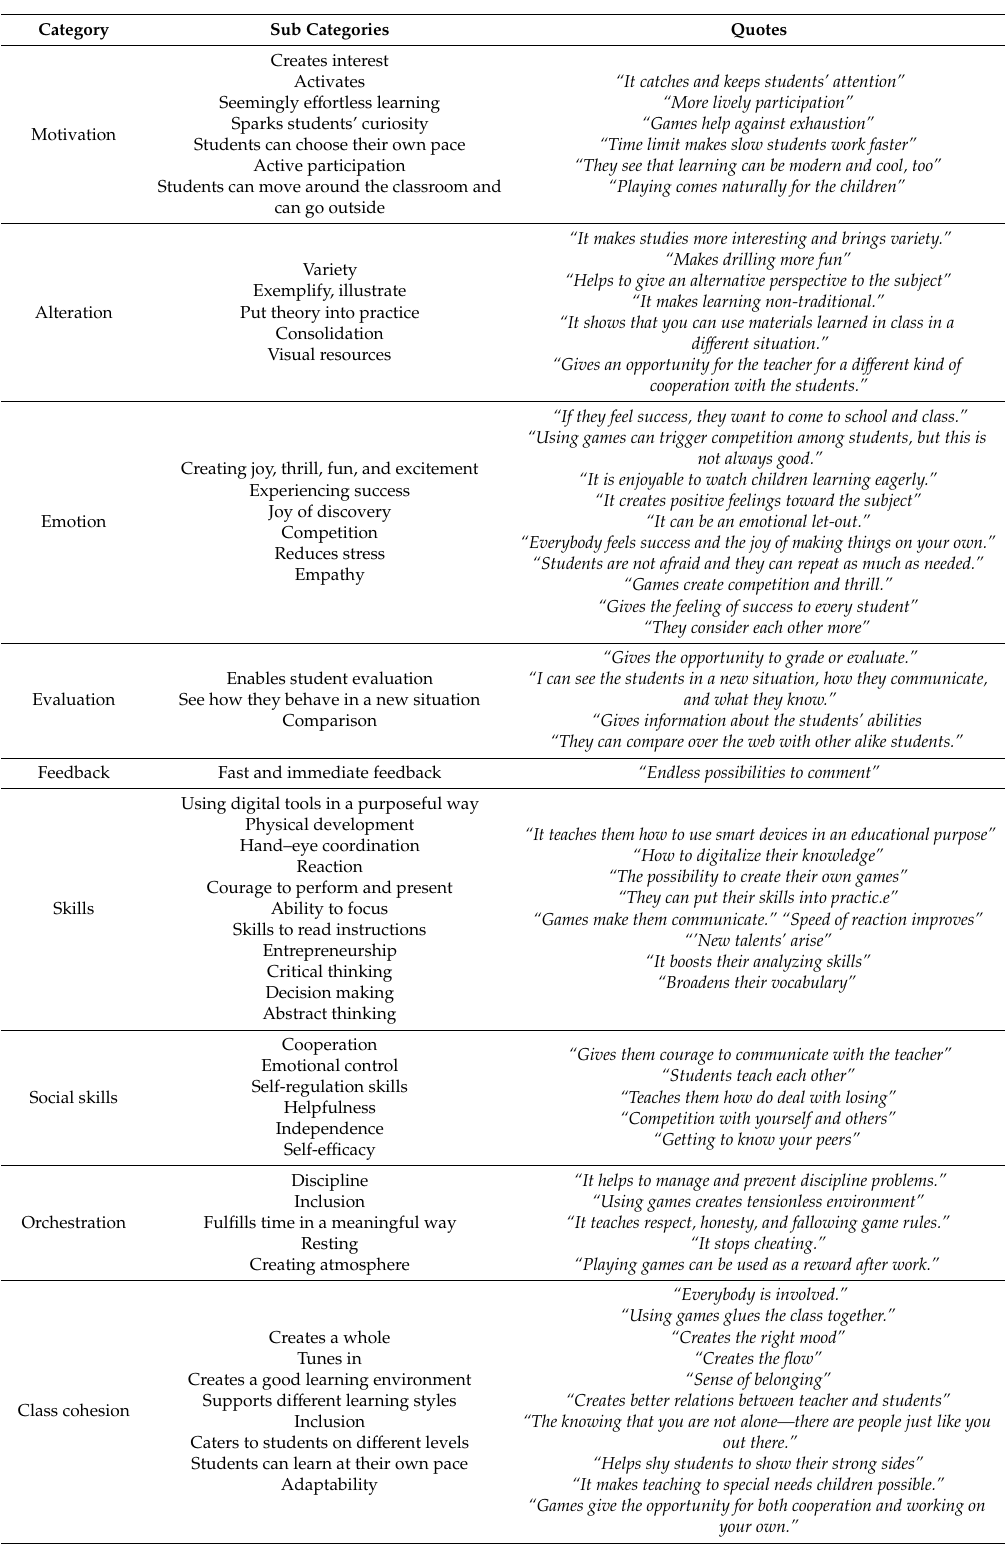
Table 5. Perceived outcomes of using games for teachers and